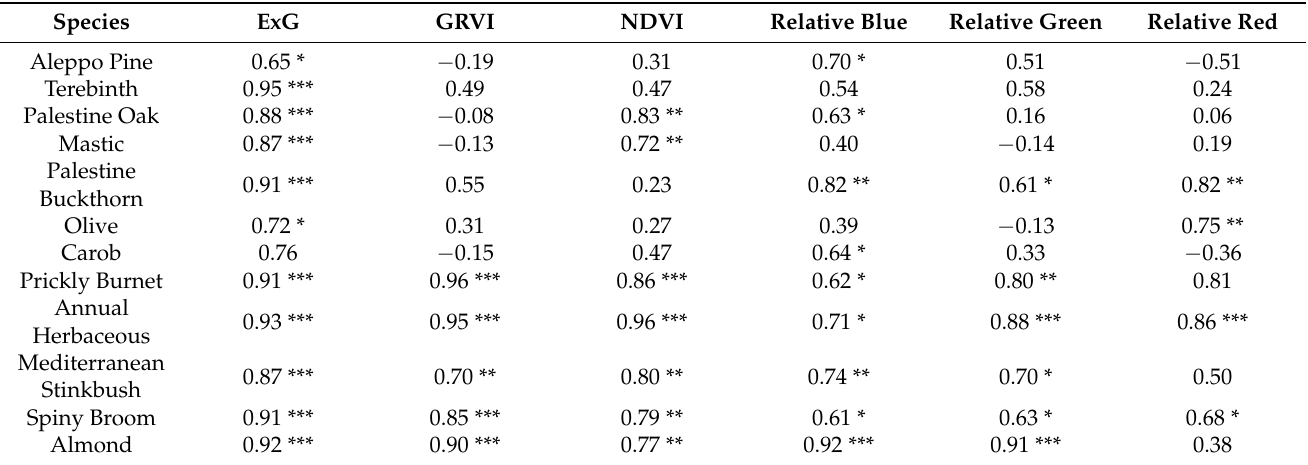
Table 4. Pearson correlation coefficients of six Vegetation Indices mean values for each species per date (11 dates), between values derived from the ground camera data (after pre-processing), and those from the UAV data (spatial resolution of 14 cm). The asterisks indicate the statistical significance as follows: * p < 0.05, ** p < 0.01, *** p < 0.001. H 0 : R 2 = 0. Species ExG